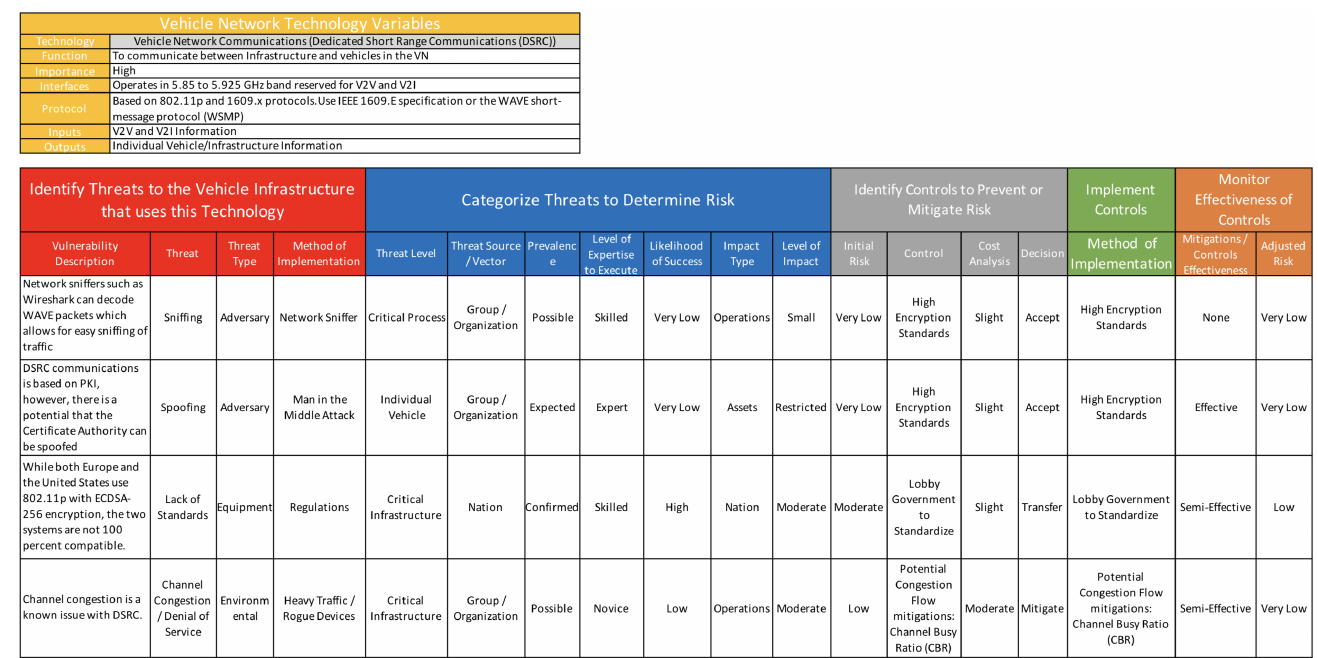
Figure 9. Vehicular Network Risk Management Process Example for